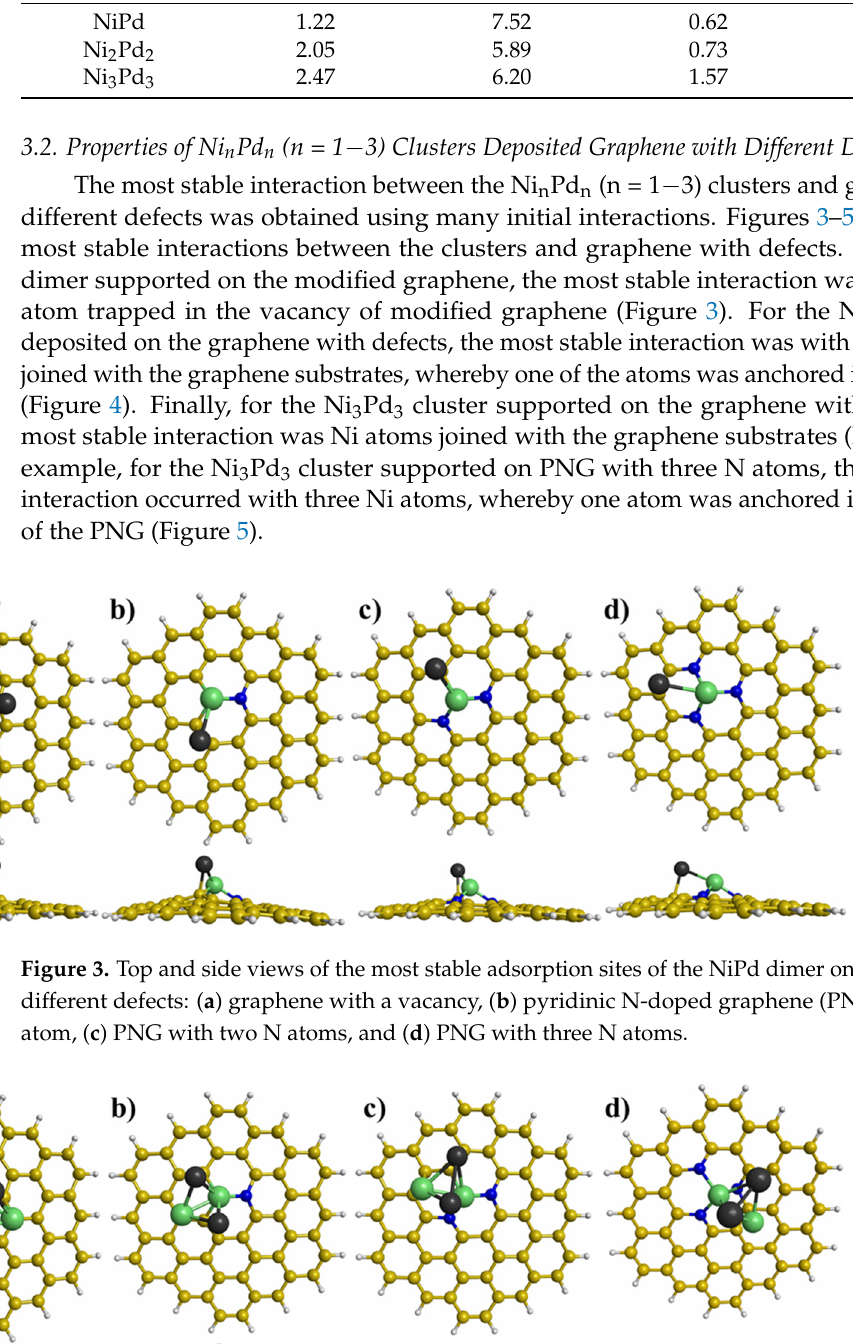
Table 1. Properties of Ni n Pd n (n = 1 − 3) clusters.